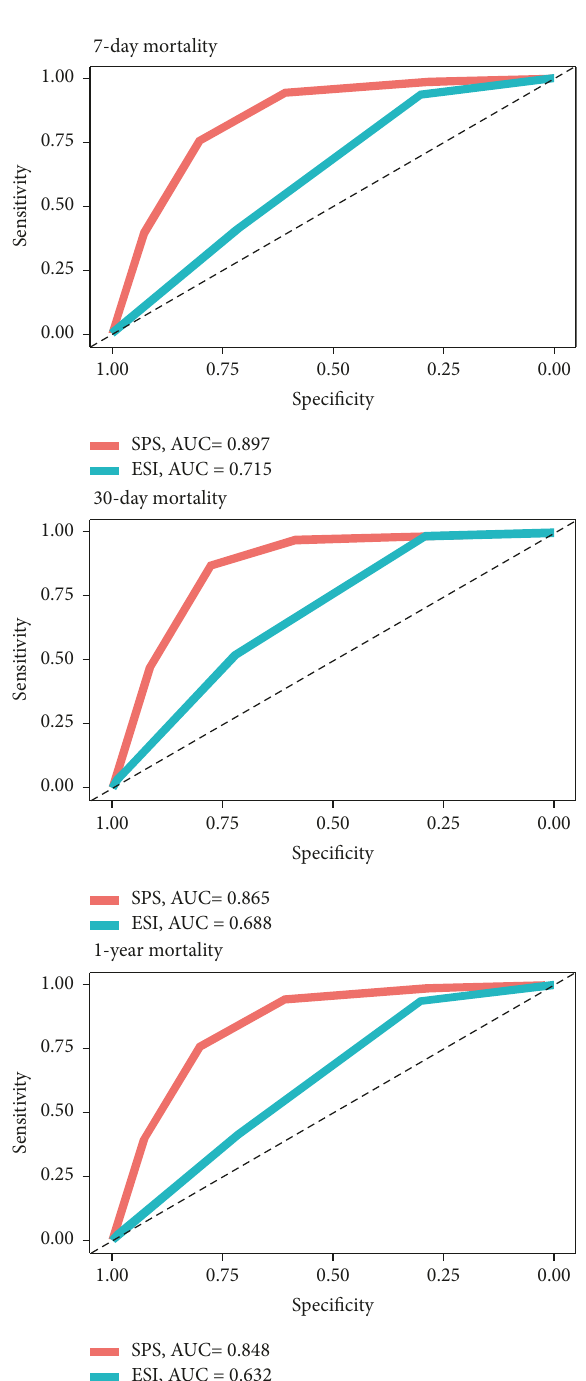
Figure 3: Receiver operating characteristic (ROC) curves. This figure shows ROC curves for emergency severity index (ESI) and the simple prognostic score (SPS) for 7-day, 30-day, and 1-year mortality. The ESI level was coded inversely for the ROC curve to lie above the diagonal. SPS, simple prognostic score,; ESI, emergency severity index; AUC, area under the